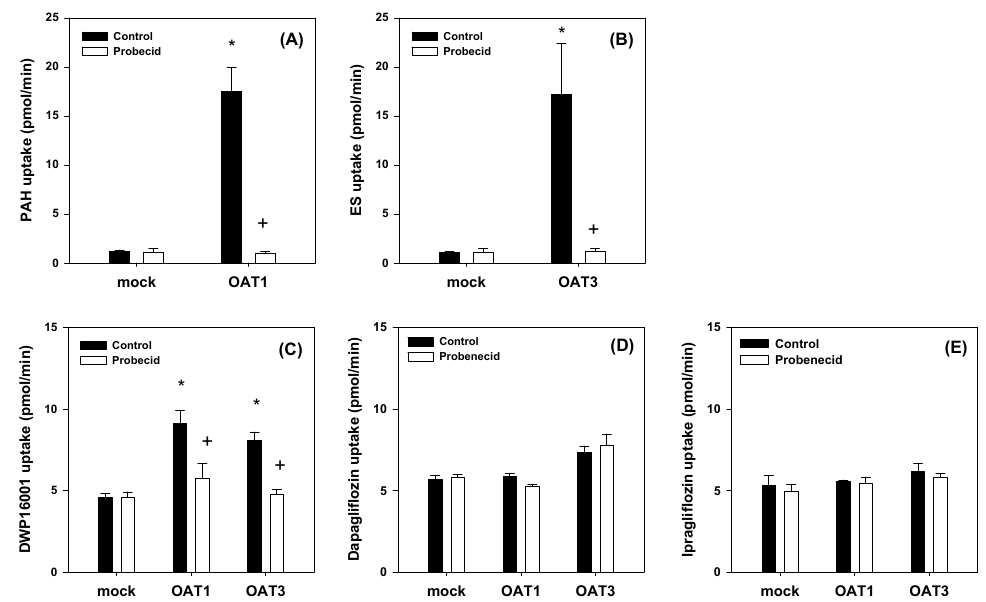
Figure 5. ( A ) Uptake of 0.1 µM [ 3 H]para-aminohippuric acid (PAH) was measured in HEK293-mock and –OAT1 cells in the presence and absence of 20 µM probenecid for 5 min. ( B ) Uptake of 0.1 µM [ 3 H]Estrone-3-sulfate (ES) was measured in HEK293-mock and –OAT3 cells in the presence and absence of 20 µM probenecid. Uptake of ( C ) DWP16001, ( D ) dapagliflozin, and ( E ) ipragliflozin (2 µM each) into HEK293-mock and HEK293 cells expressing OAT1 and OAT3 was measured for 5 min. Each data point represents the mean±standard deviation of triplicate experiments. *: p < 0.05, compared with mock cells; +: p < 0.05, compared with control group.